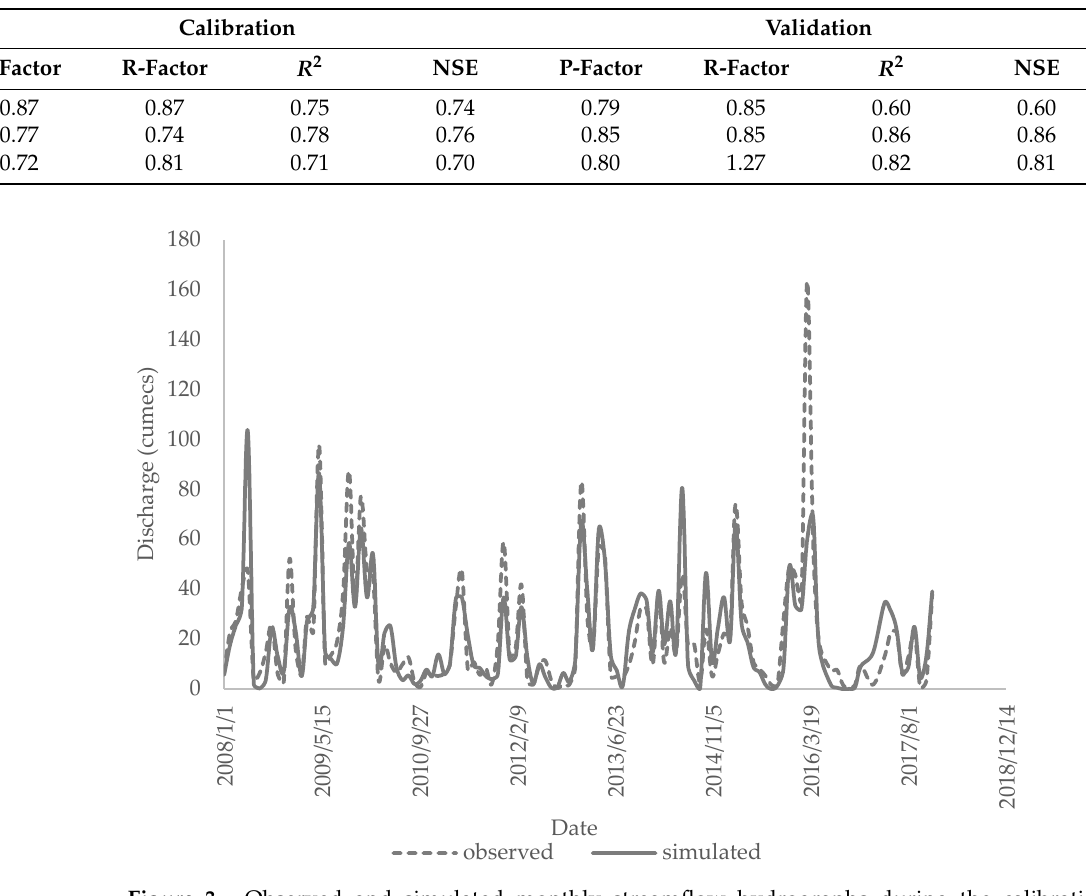
Figure 3. Observed and simulated monthly streamflow hydrographs during the calibration (2008–2012) and validation (2013–2017) periods for Merigold USGS gauge station.